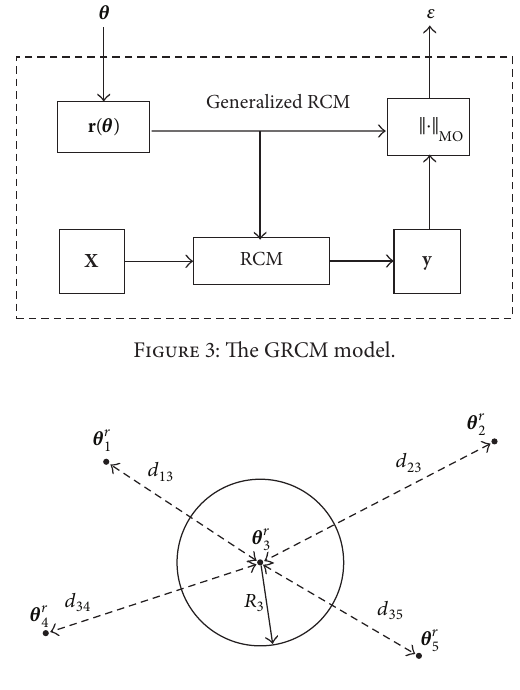
Figure 4: The hypersphere for the reinitialization.